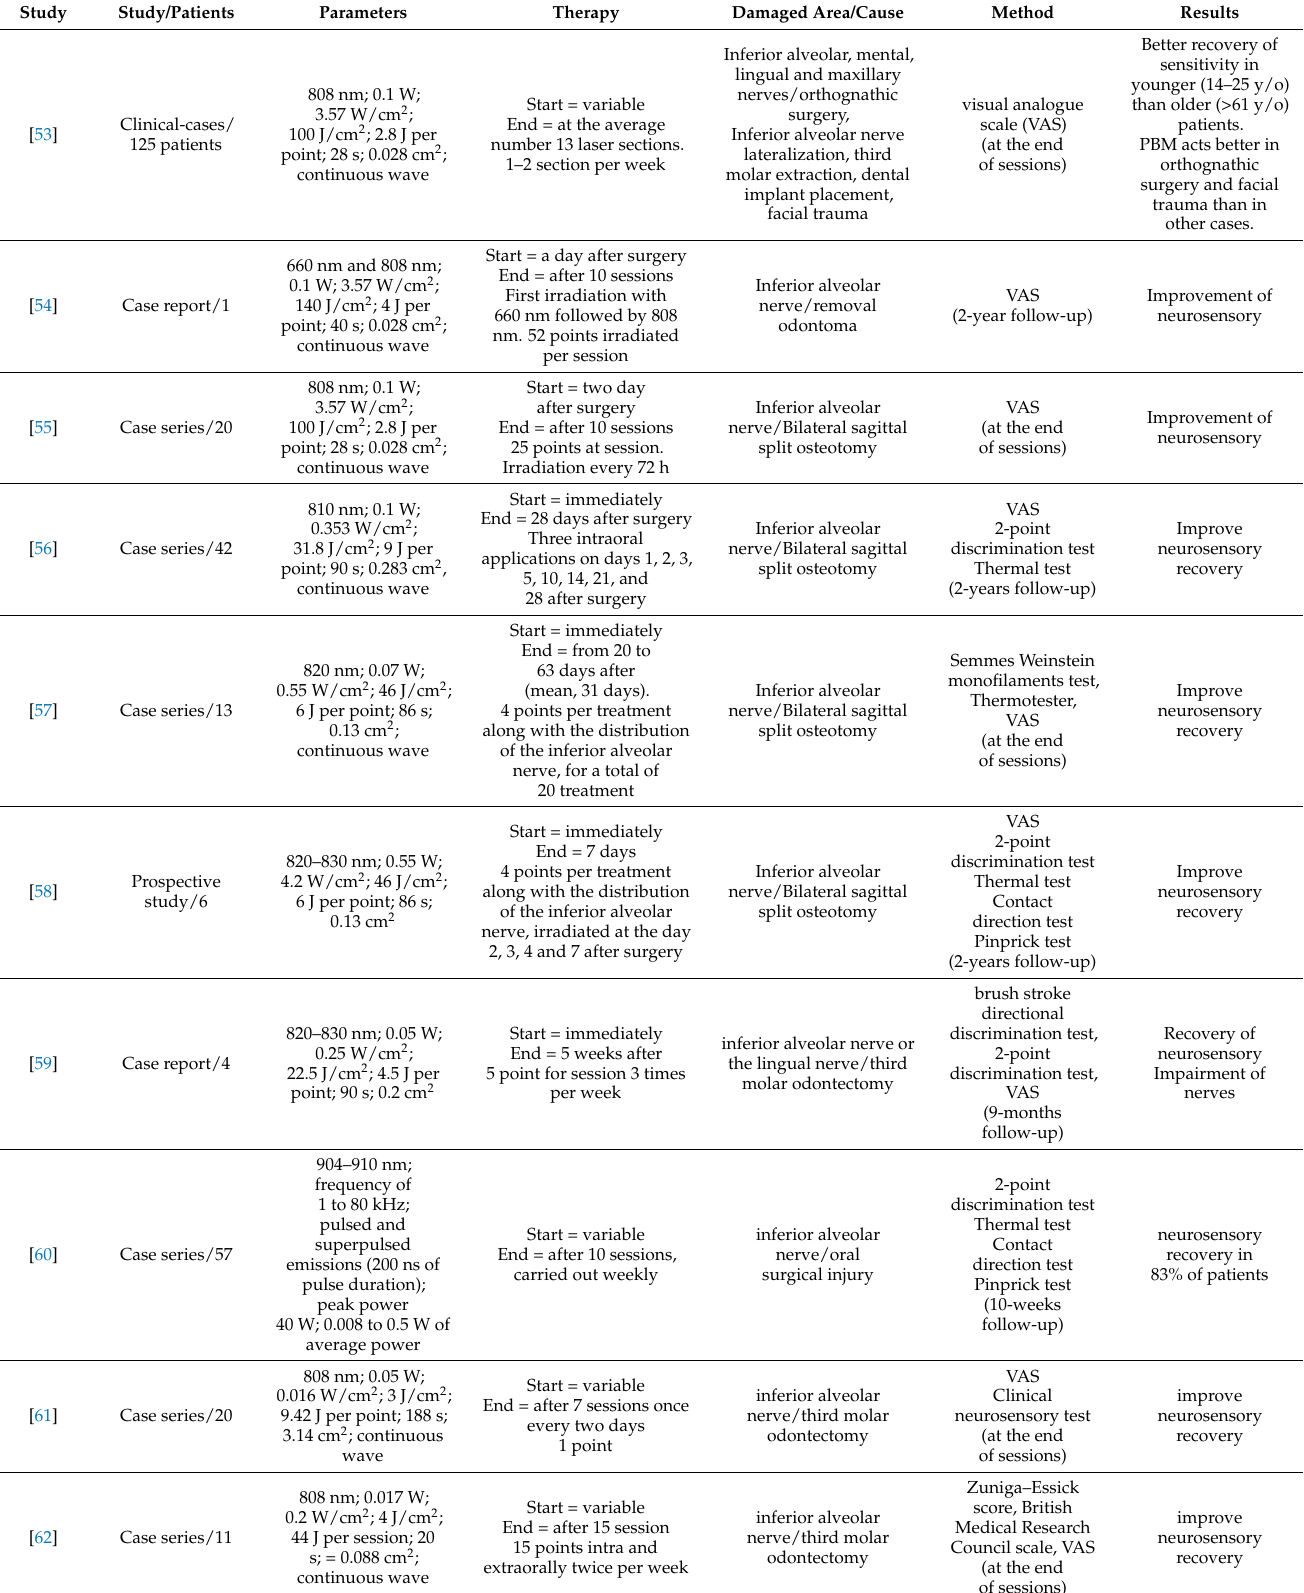
Table 3. No RCT clinical studies on photobiomodulation and trigeminal branches nerves recovery, selected after inclusion and exclusion criteria. The table shows the schematic design of the experimental set-up on patients and the